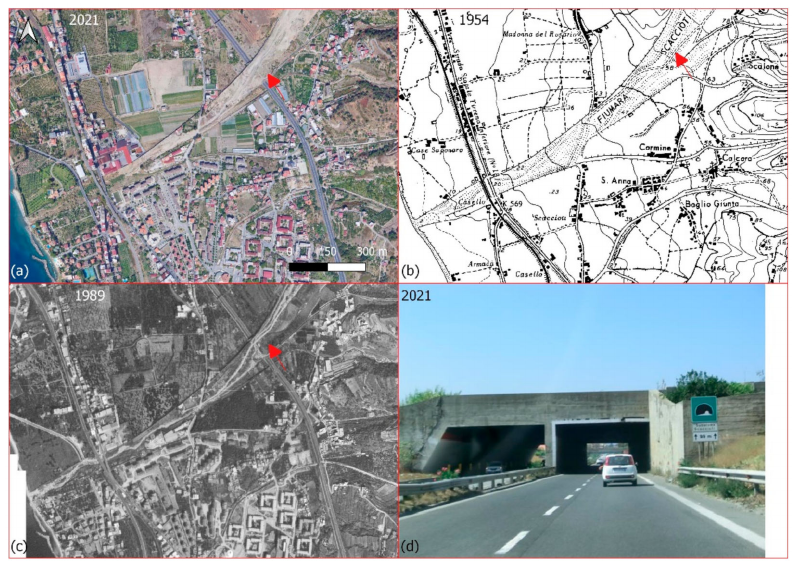
Figure 9. The Scaccioti River. ( a ) An image from Google Earth from September 2021. ( b ) The CASMEZ cartography from 1954. ( c ) The orthophoto from 1989. ( d ) The view of the highway under the river. The arrows identify the highway tunnel under the